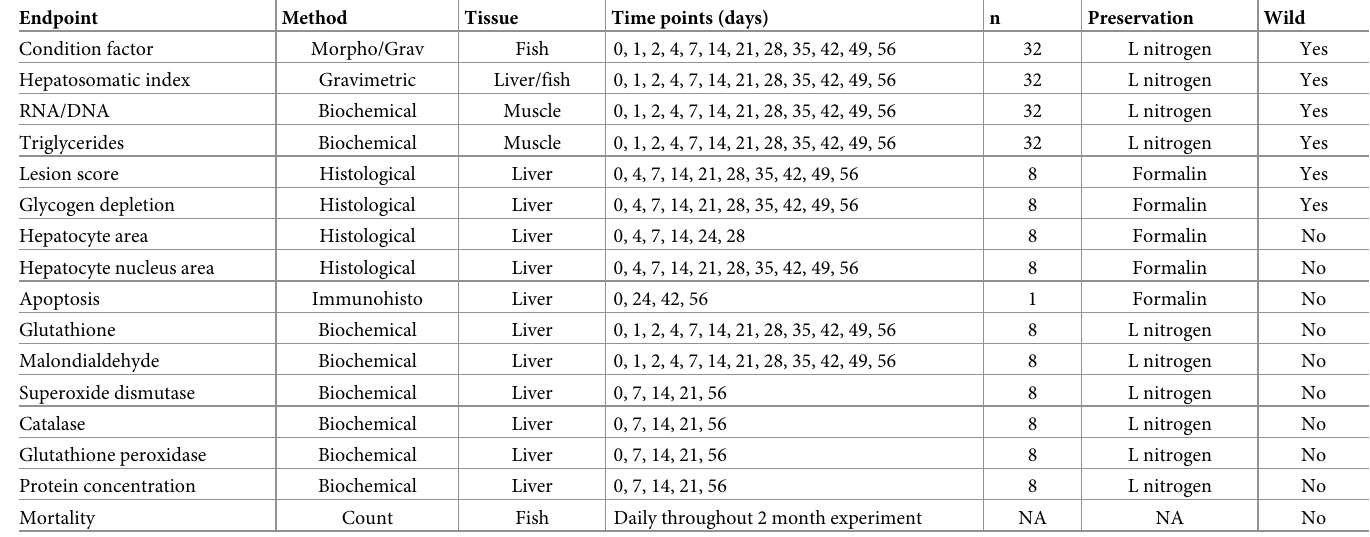
Table 1. Sampling time points, details, and effort for each endpoint examined in the study. Preservation is the initial method used to preserve the fish, ‘n’ refers the number of fish per time-point (i.e., for condition factor 16 fish were used from each treatment), and ‘Wild’ refers to whether the endpoint was also measured on wild fish. Endpoint